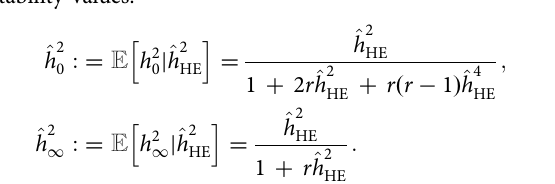
Fig. 1 Theoretical and empirical behavior of existing and corrected estimators. HE regression ( ^ h 2 mate correlations ( r ) in simulated datasets ( n = 64,000) assuming that h 2 equilibrium. Values of ^ h 2 are consistent with our closed-form approximation ( E ½ ^ h 2 HE estimators, ^ h 2 and ^ h 2 , which are based on ^ h 2 and r and assume equilibrium, recover the true equilibrium ( h 2 0 HE a given observation of ^ h 2 for a trait under disequilibrium AM, the current generation heritability ( h 2 t ) and h 2 HE (teal and red regions respectively; see main